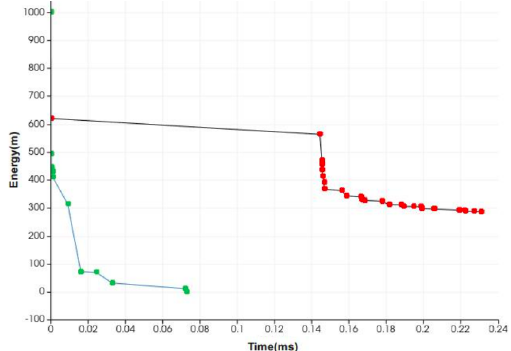
Figure 4. Comparison of the convergence speed and the robustness of RANSAC and simulated annealing: X axis represents time in milliseconds, Y axis represents the energy, green points represent the minimums estimated by RANSAC and the red points represent the minimums estimated by simulated annealing started by clustering the 3D segments of each data set. The clusters are associated to find possible rotations, then 3D seg- ments from associated clusters are matched in order to find the translation and scale factor minimizing the defined